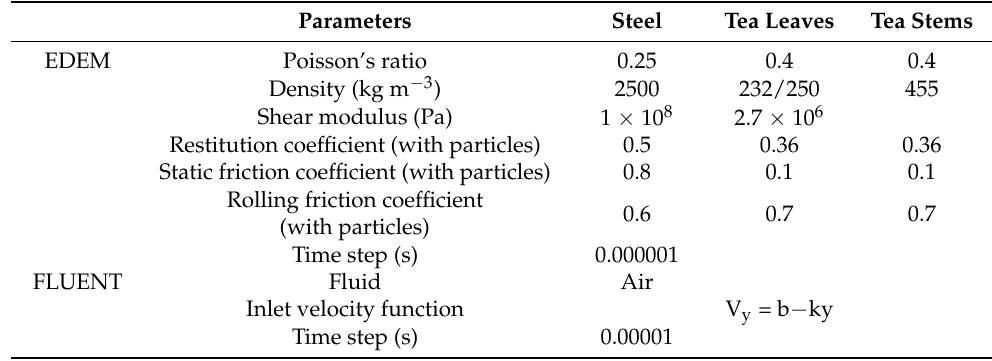
Table 2. Simulation